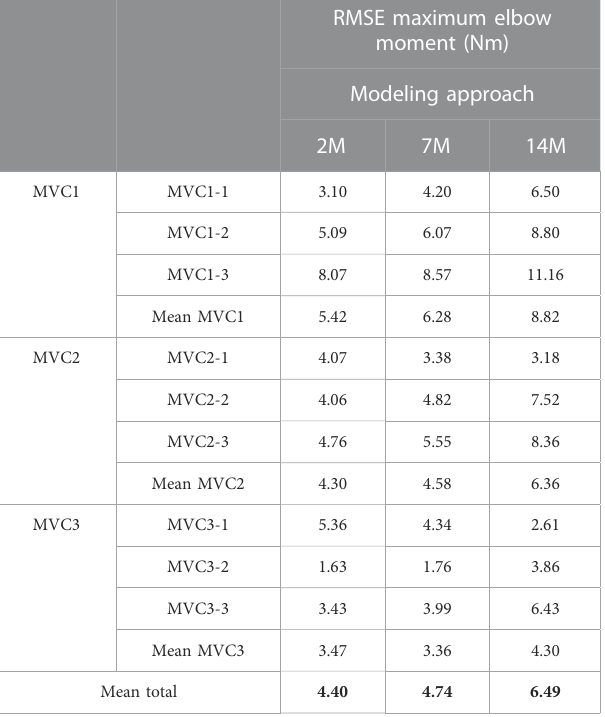
TABLE 3 First elbow moment peak error using physiological optimization. RMSE maximum elbow moment (Nm)